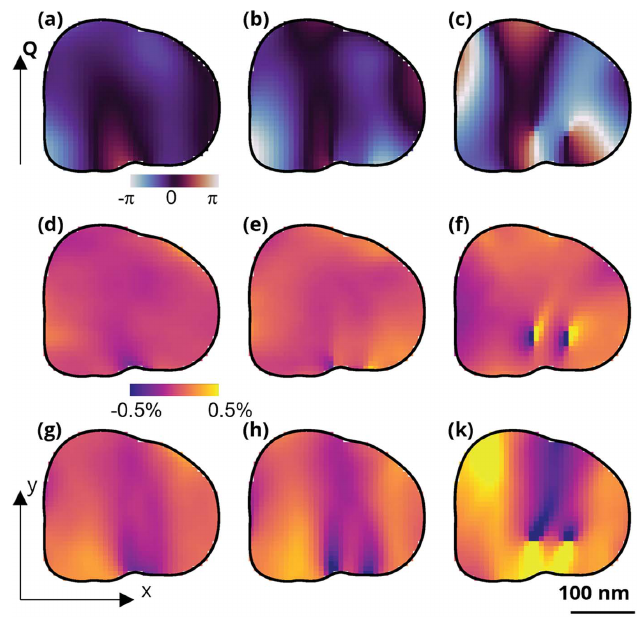
Figure 3 Shear gradient calculated from the operando imaging data experiment described in Singer et al. (2018 a ). ( a – c ) Cross-sections of the displacement field within a single grain at different stages of the battery charging. ( d – f ) Strain field, @ u y / @ y . ( g – k ) Displacement gradient @ u y / @ x perpendicular to the Q vector proposed in this work. Charge states 1 ( a , d , g ), 2 ( b , e , h ), and 3 ( c , f , k ) correspond to charging a lithium-rich layered oxide particle at voltages of 4.0 V, 4.2 V, and 4.3 V,